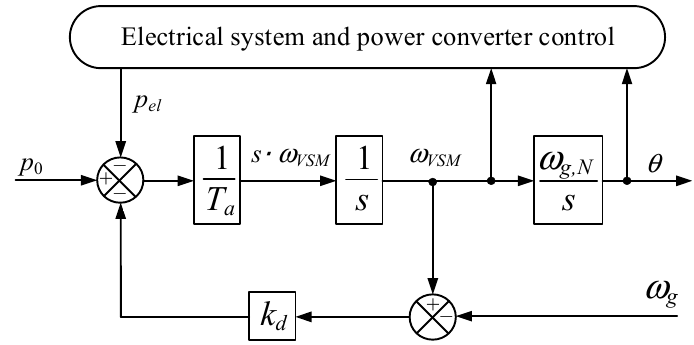
Figure 8. Emulation of inertia by a virtual synchronous